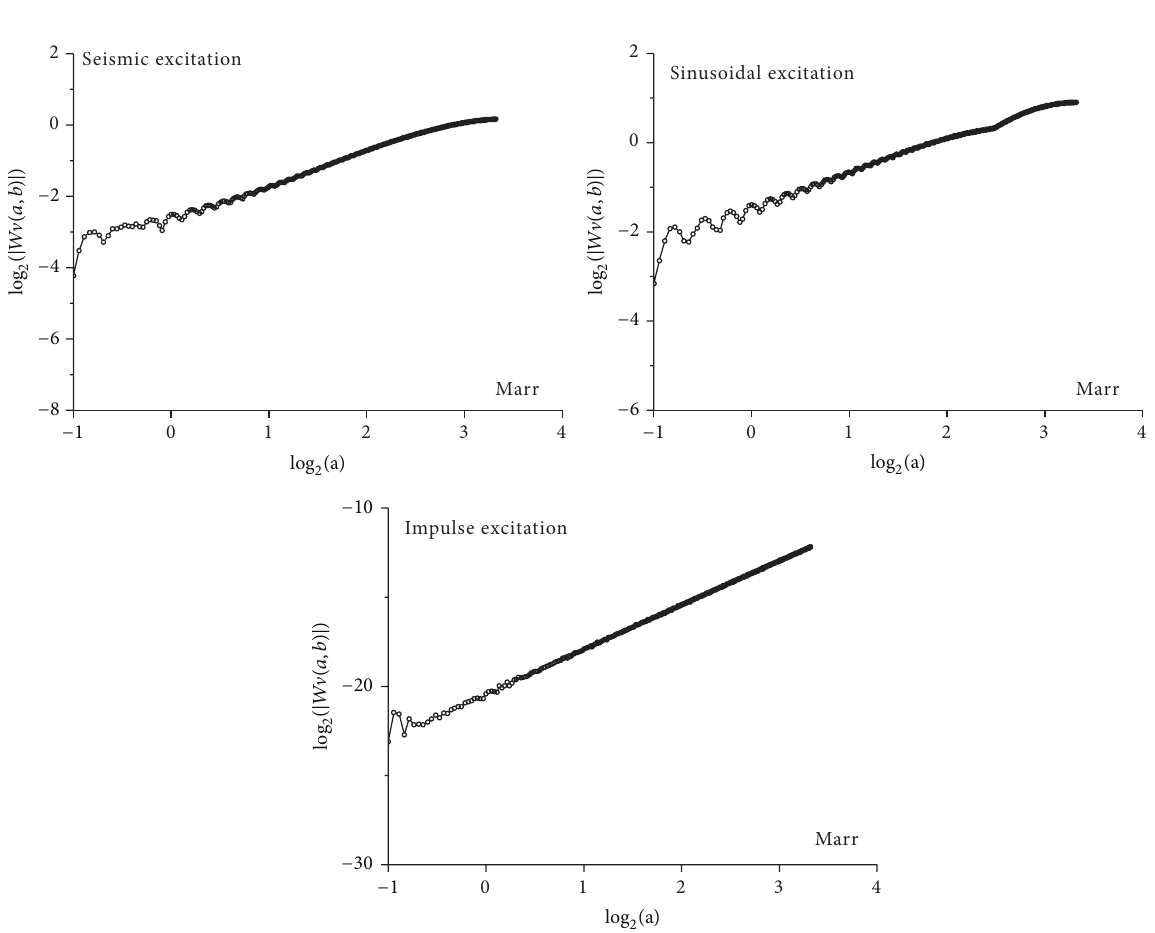
Figure 8: Decay behaviour along the modulus maxima line under seismic excitation.